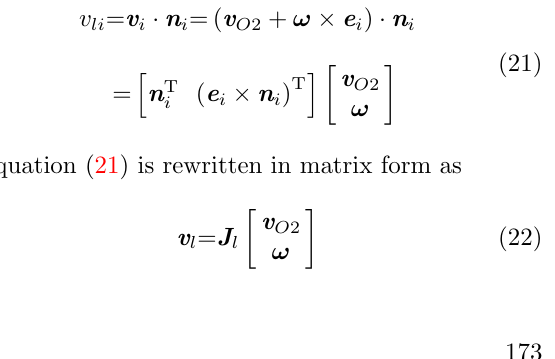
Table 1: The vectors used in Figure 6 ( 1,2,3,4 i = )